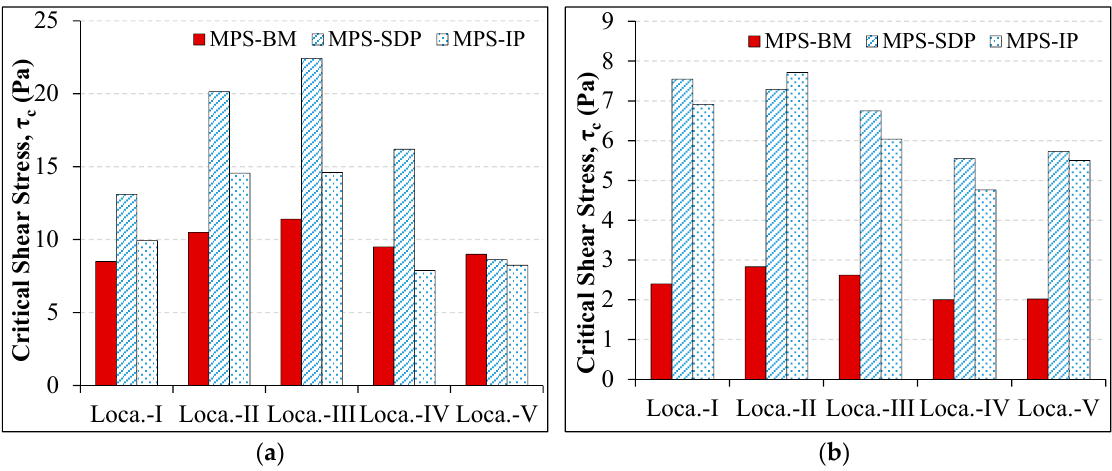
Figure 4. Based on the MPS method at the Gist Creek study site, critical shear stress ( τ c ) estimates for the: ( a ) lower bank and ( b ) upper bank among the five test locations (Loca-1, -II, -III, -IV, and -V) and shown for the MPS-BM, MPS-IP, and MPS-SDP computational procedures.